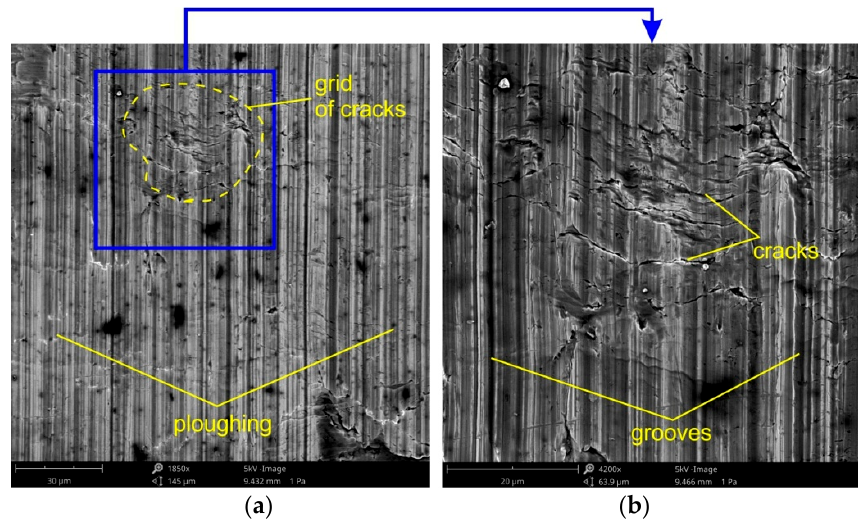
Figure 22. The specimen surfaces tested in dry friction (Ra = 0.63 μ m, h = 18 mm, w = 14 mm, orientation 0°) at different magnifications: ( a ) ×1850 and ( b ) ×4200.